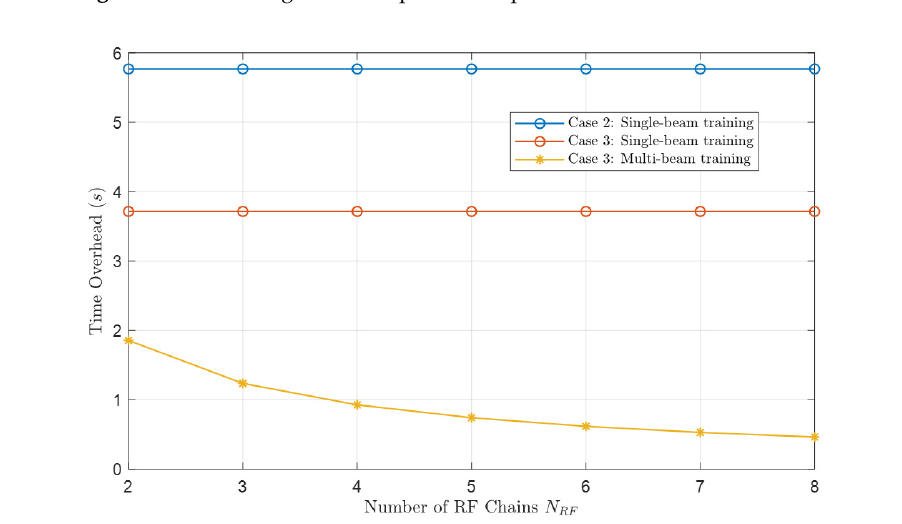
Figure 13. Time overhead comparison of single-beam training and multi-beam